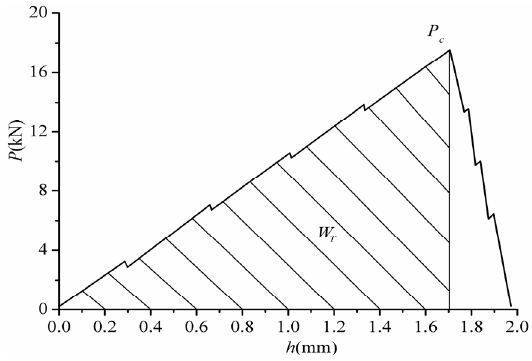
Figure 7: Variation curve of cutting force.